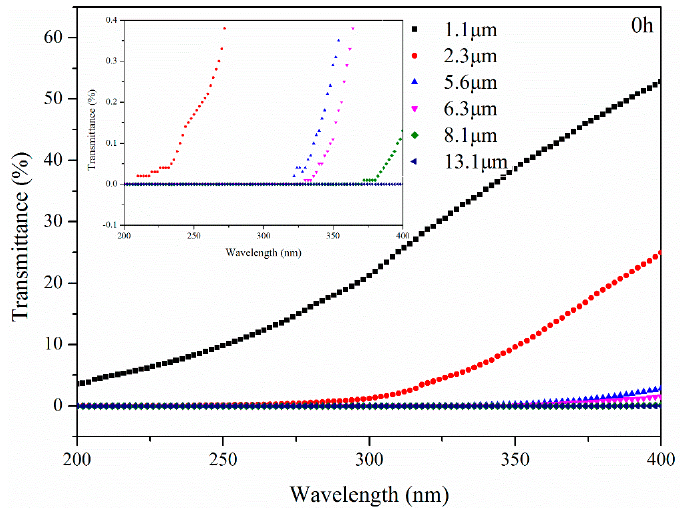
Figure 11. Transmittance of bitumen with different thicknesses after UV aging for 0 h.